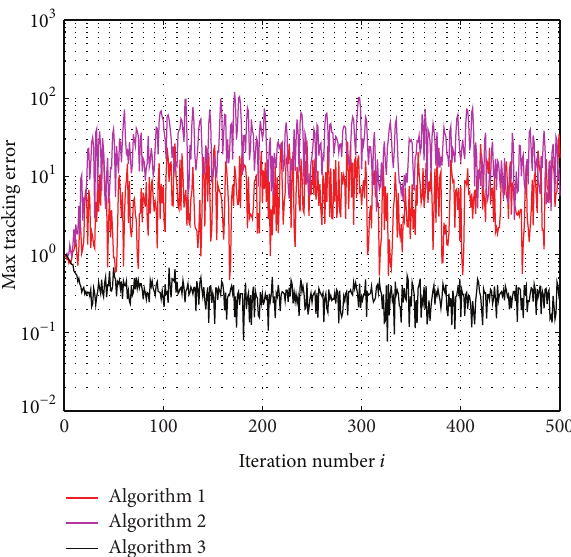
Figure 3: The mathematical expectation of the tracking error versus iteration with 5% packet